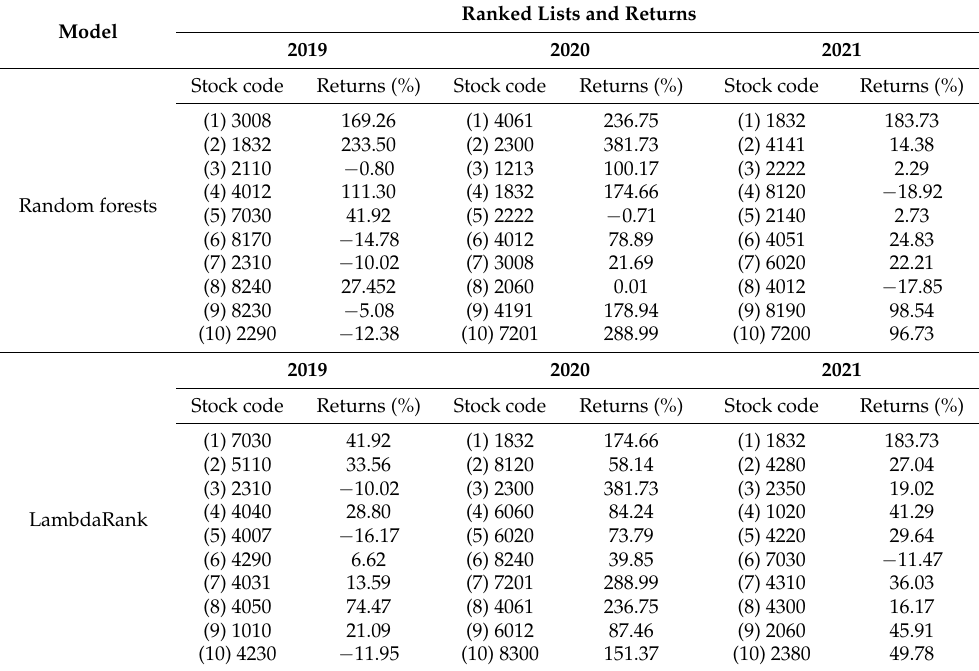
Table 10. A sample of the ranked list of results showing the selected stock symbols (top 10) and their returns for two models, Random forests and LambdaRank. The table shows the results for the